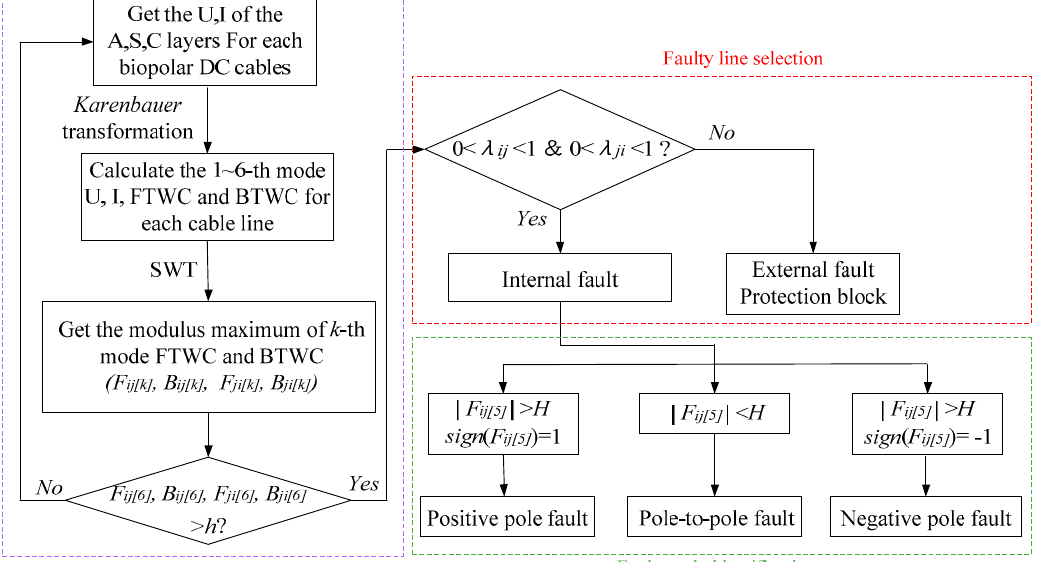
Figure 7. Flow chart of the proposed fault location scheme.